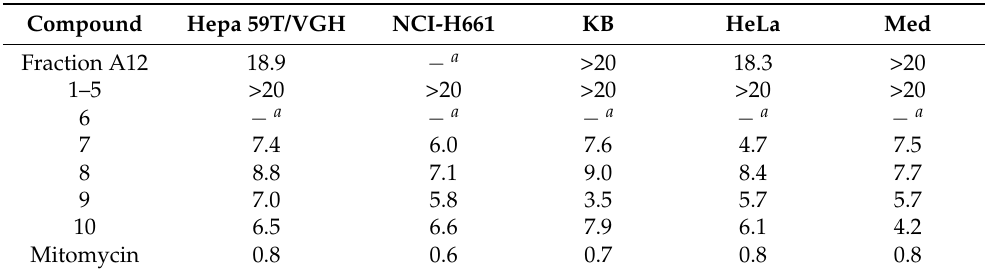
Figure 1. Metabolites isolated from the anemone Condylactis sp. Table 2. Cytotoxicity (IC 50 μ g/mL) of fraction A12 and metabolites 1 ‒ 10 of Condylactis sp.